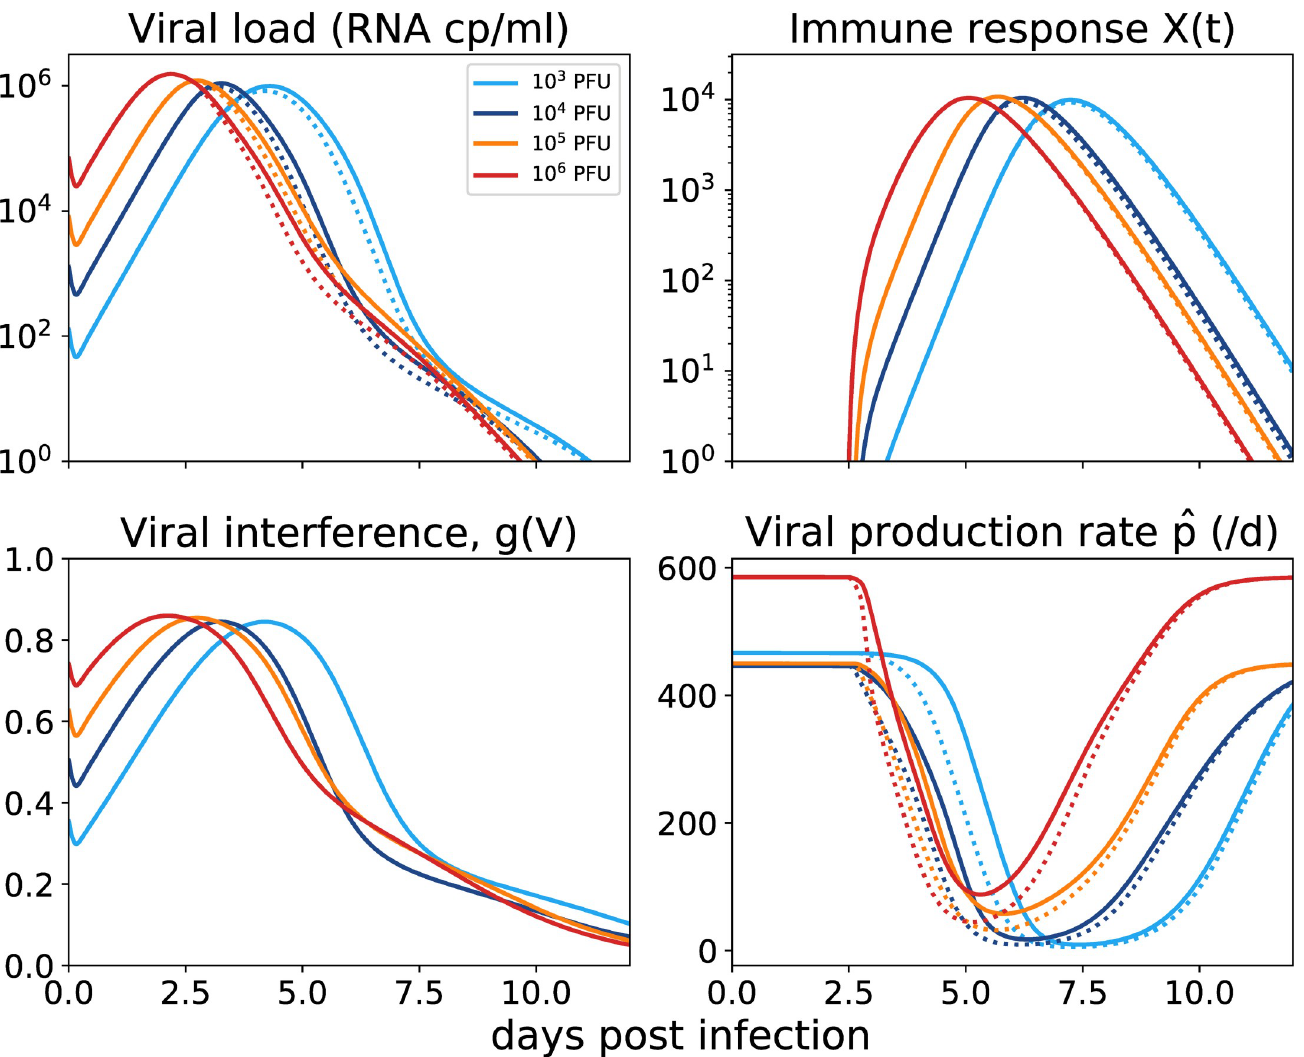
Fig 4. Predicted dynamics for the immune response model with viral interference (Eqs 2 and 3, Table 1). Each inoculum dose is indicated by color, with the mean predicted dynamics within an inoculum group shown. The solid line shows the model dynamics with the estimated parameters. The dotted line shows the model dynamics with estimated parameters but with g (V) fixed at 0, such that viral interference has no effect on immune